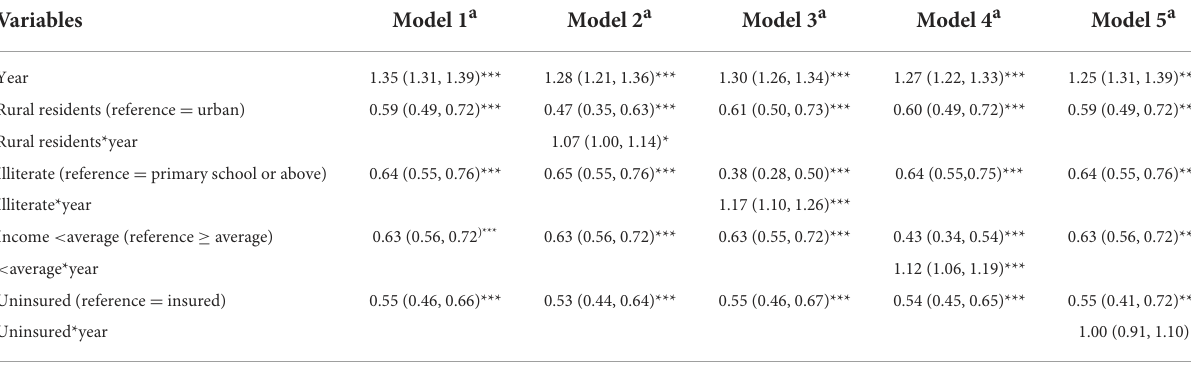
TABLE 3 Random effect model for pharmacological treatment of adults with schizophrenia: odds ratio and 95% CI.